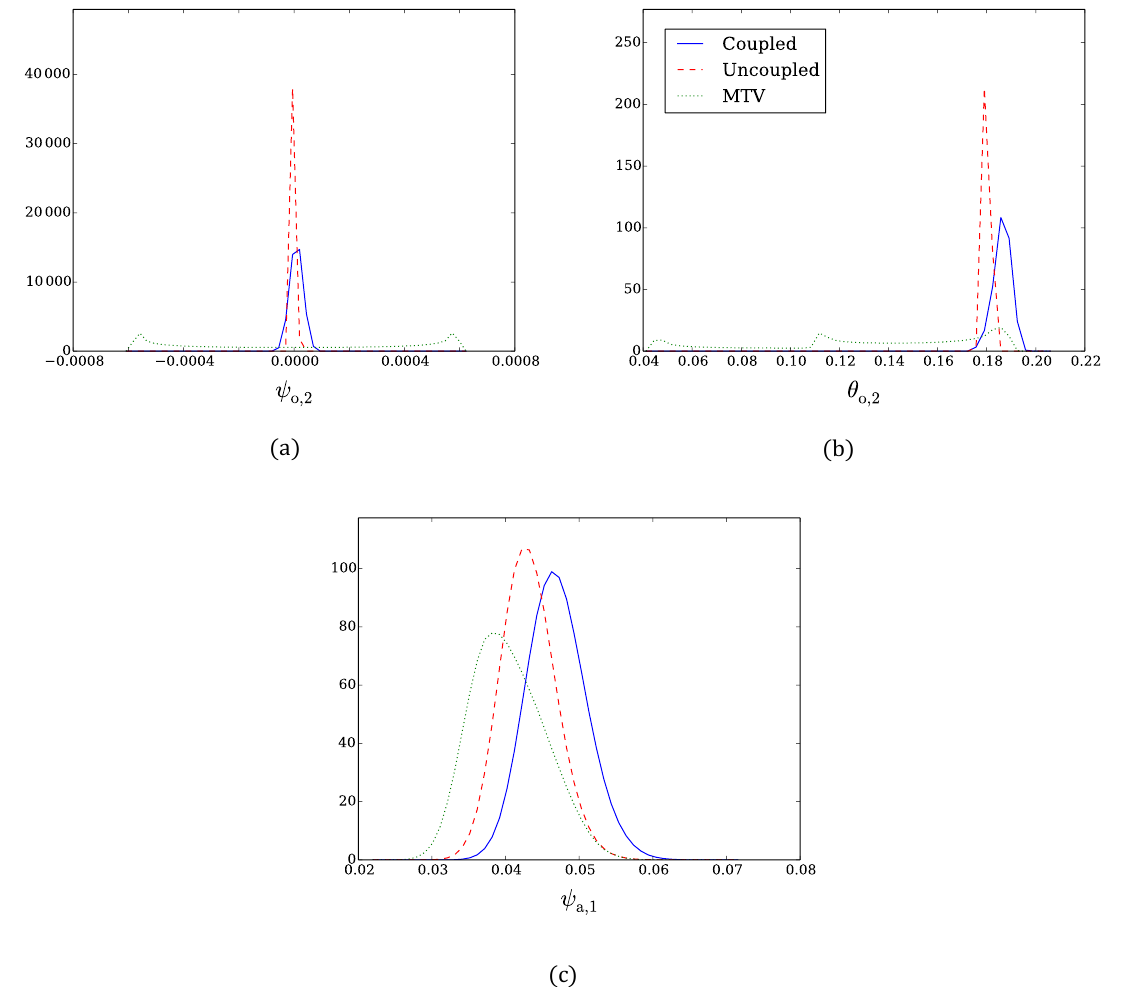
Figure 7. Probability density functions (PDFs) of the dominant variables of the system dynamics as in Fig. 2, but for the wavenumber 2 parameterization. It is shown for the parameter set noLFV but with the wind stress parameter set to d = 0 . 5 × 10 − 9 and for which the MTV parameterization depicts a false